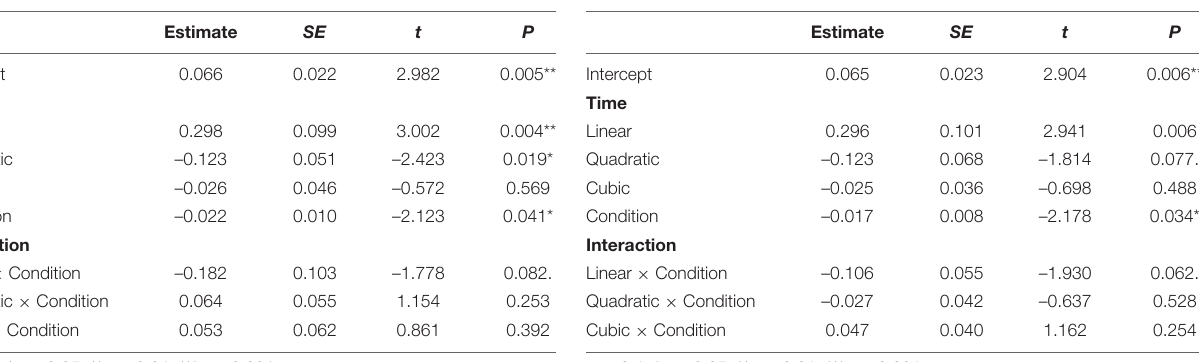
TABLE 5 | Results of growth curve analysis on Mandarin listeners’ proportions of fixations to CR-T2 targets and CR-T2